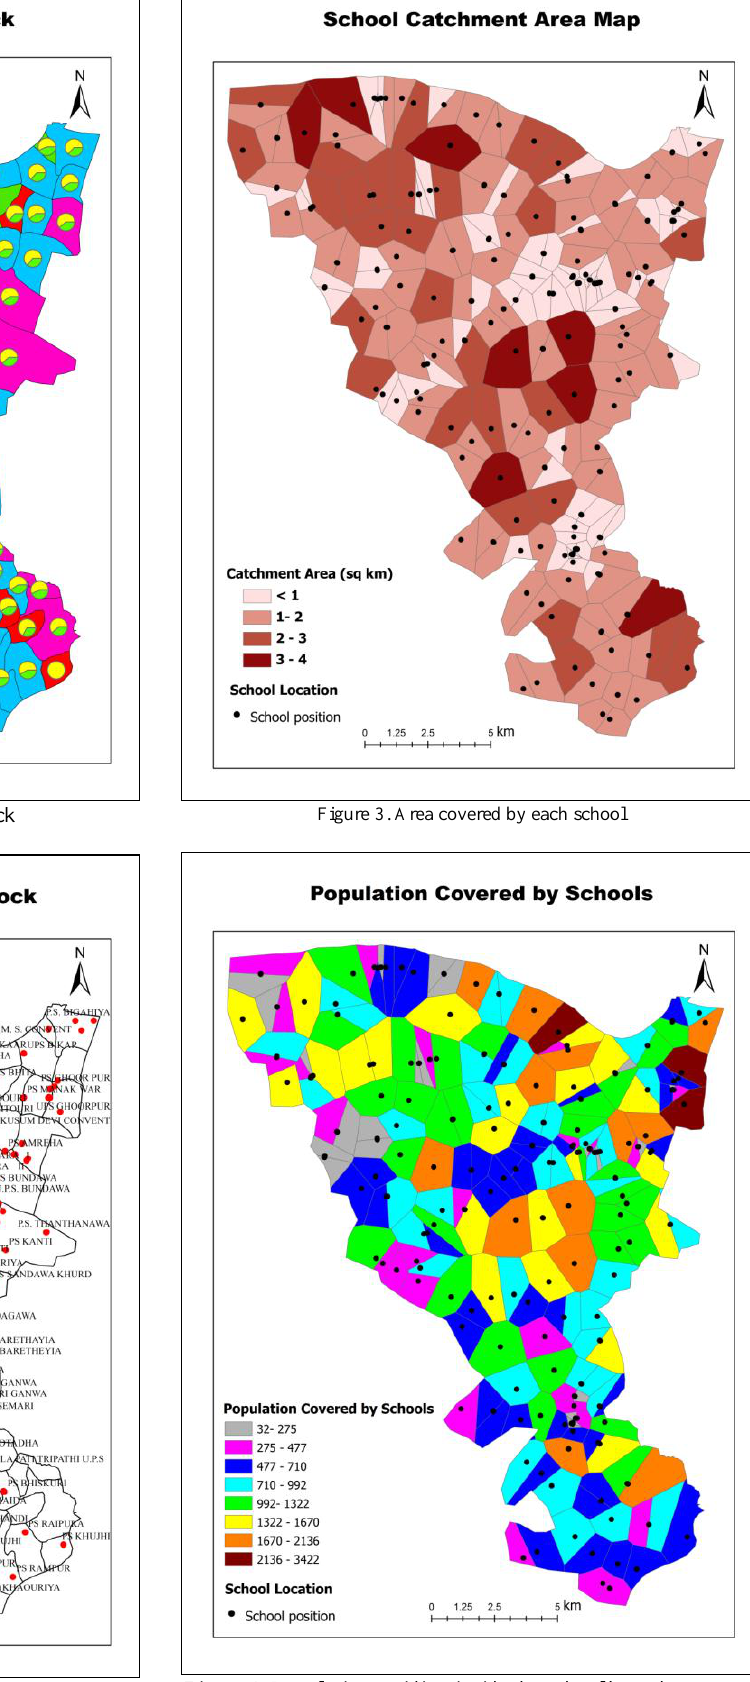
Figure 4. Population residing inside the school's catchment